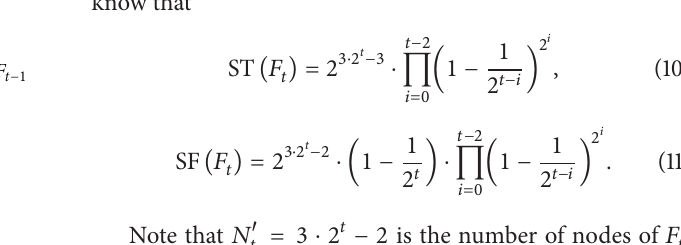
Figure 3: The network models 𝑈 𝑡 and 𝐹 𝑡 at step 𝑡 .